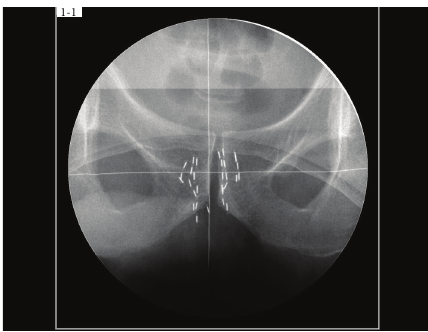
Figure 2: Pelvic X-ray image after salvage